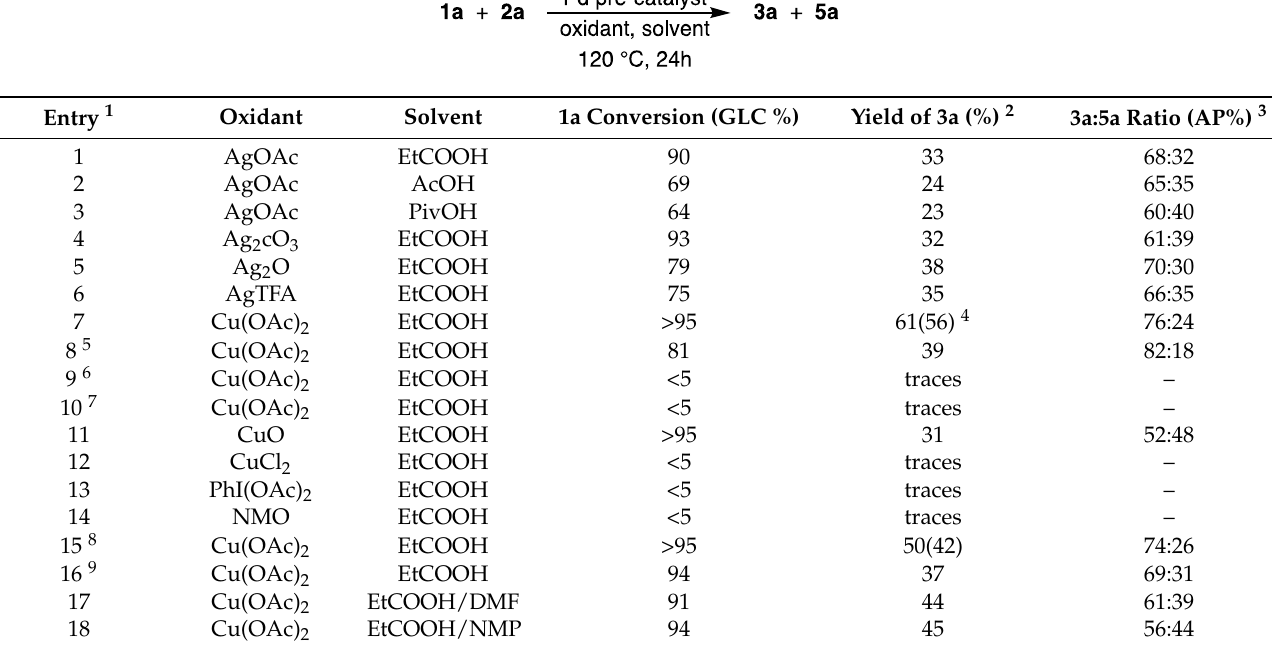
Table 1. Screening of the reaction conditions for the palladium-catalyzed dehydrogenative alkenylation of 1-methyl-5 (4-methoxyphenyl)imidazole ( 1a ) with styrene ( 2a ).